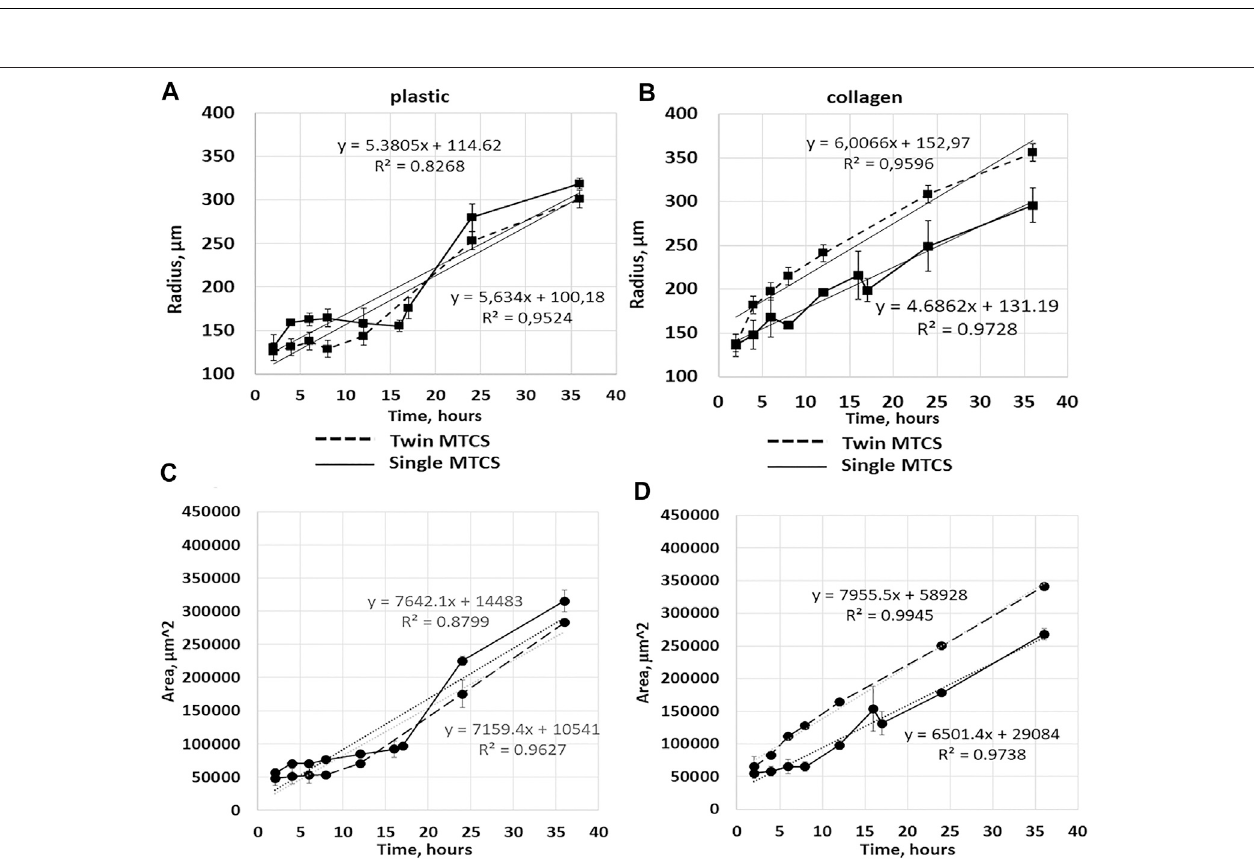
FIGURE 5 | Cell migration from single MCTS and twin MCTS on plastic and collagen gel. (A) Average radius of cell migration from single MCTS and twin MCTS planted on plastic substrate (B) Average radius ofcell migration from single MCTSand twinMCTS planted on collagen gel. (C) Average areaofcell migration from single MCTSand twinMCTSplanted on plastic substrate (D) Average areaofcell migration from single MCTSand twin MCTSplanted oncollagengel.The dataare presented asthe mean ± SD. Linear trend(dotted line)represent meanexpansionspeedover 24 h withtrendparametersshown inthegraph.Correspondingdatavalues are shownin SupplementaryTablesS1,2,4 .expansionspeedsodrastically(5,385c.u.vs5,634c.u.forsingleandtwinMCTS,respectively( Figure3 , Supplementary Table S4 )), especially in the early stages.